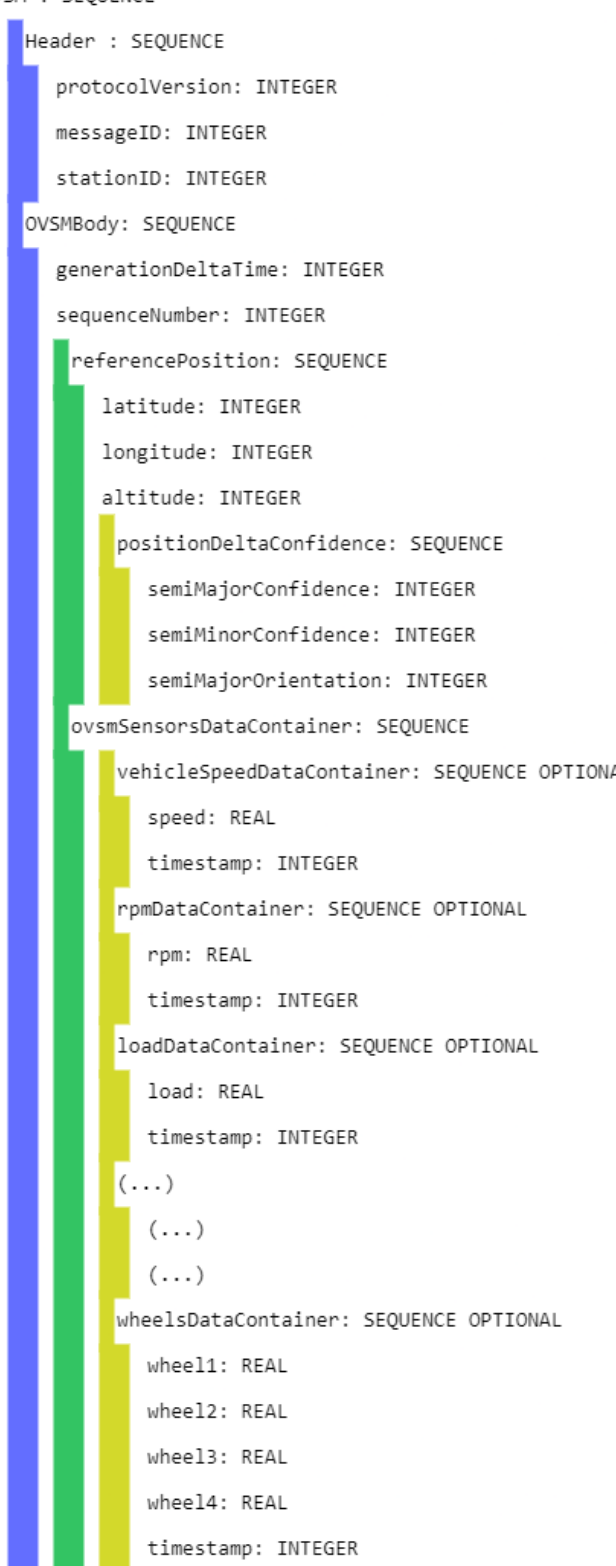
Figure A1. OVSM ASN.1 message